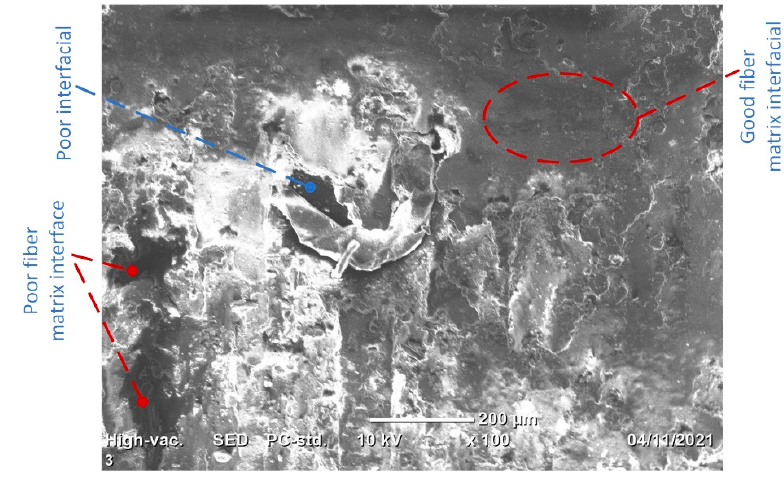
Figure 8. SEM image of 100/0 of enset–sisal hybrid composite.